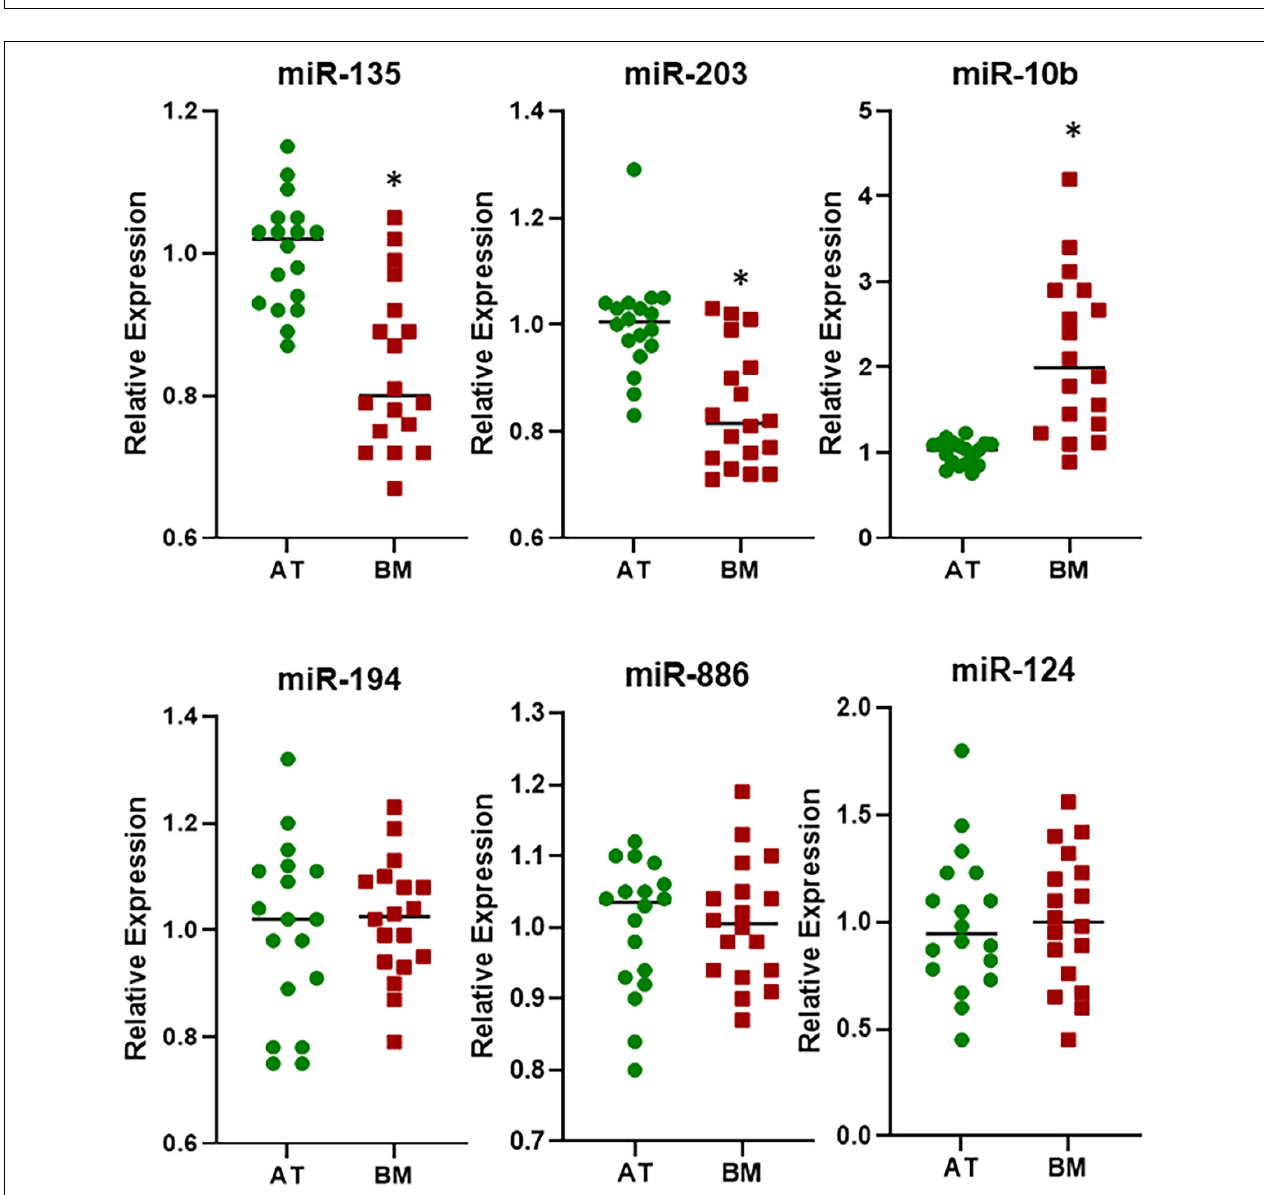
FIGURE 2 | Differential expression of miRNAs in lung cancer cohort. miRNAs were evaluated by qRT-PCR for their expression levels in BM from patients with primary lung cancer, relative to their expression in the AT. ∗ p < 0.01.